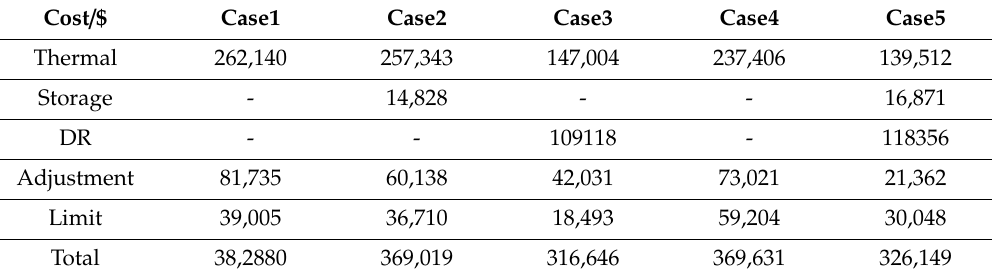
Table 4. Optimal scheduling costs in different system scenarios.